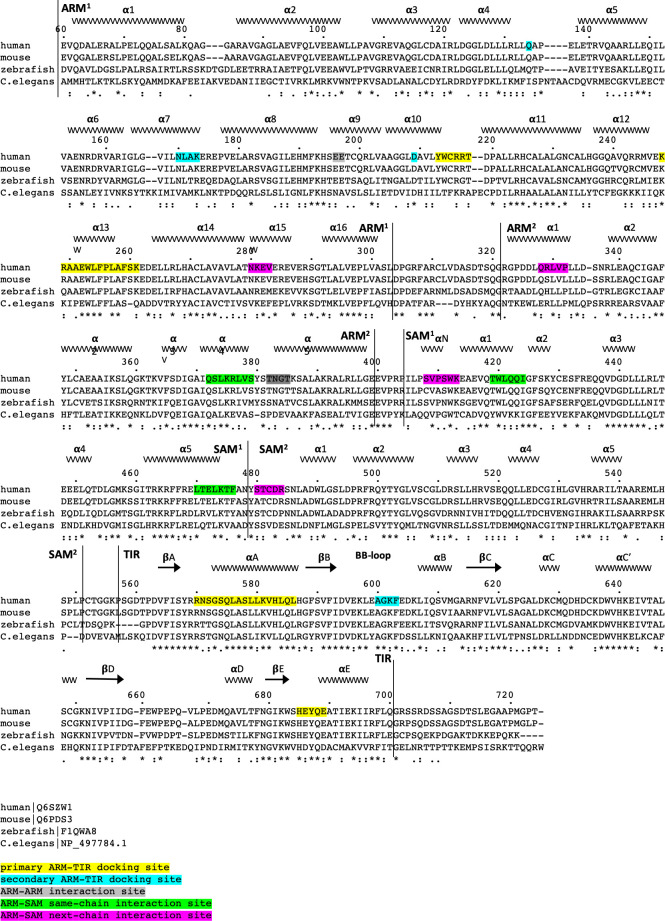
Structure-based sequence alignment of the SARM1 of human, mouse, zebrafish, and the Caenorhabditis elegans homolog TIR-1.Color-coded highlights and Uniprot protein accession numbers are listed in the figure.